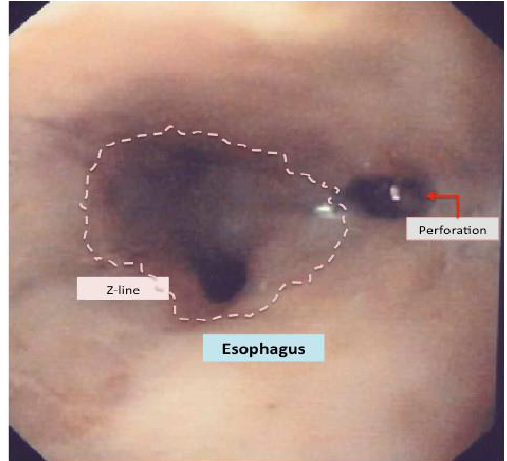
Figure 4. Endoscopic view of a distal spontaneous perforation 24 h after the presentation of clinical symptoms. However, endoscopic appearance may suggest a period exceeding at least 36 to 48 h from the presentation of